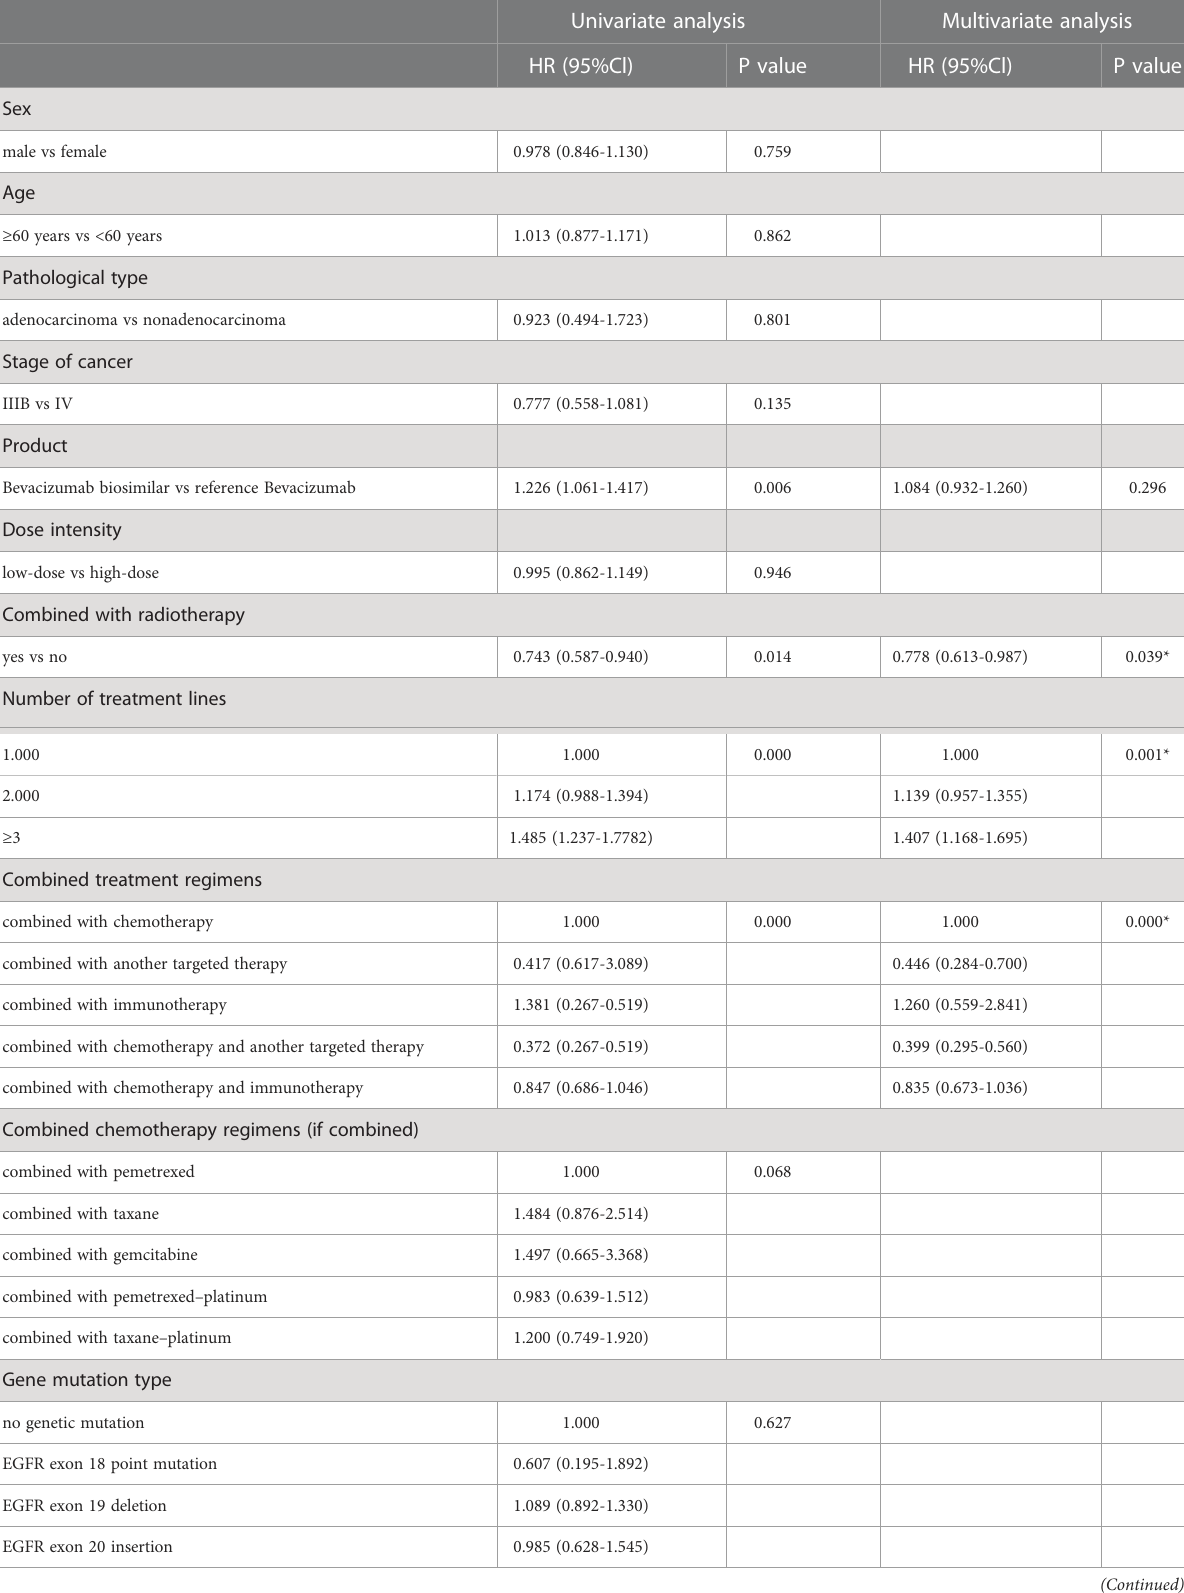
TABLE 4 Univariate analysis and multivariate analysis of factors affecting the progression-free survival (PFS) of all